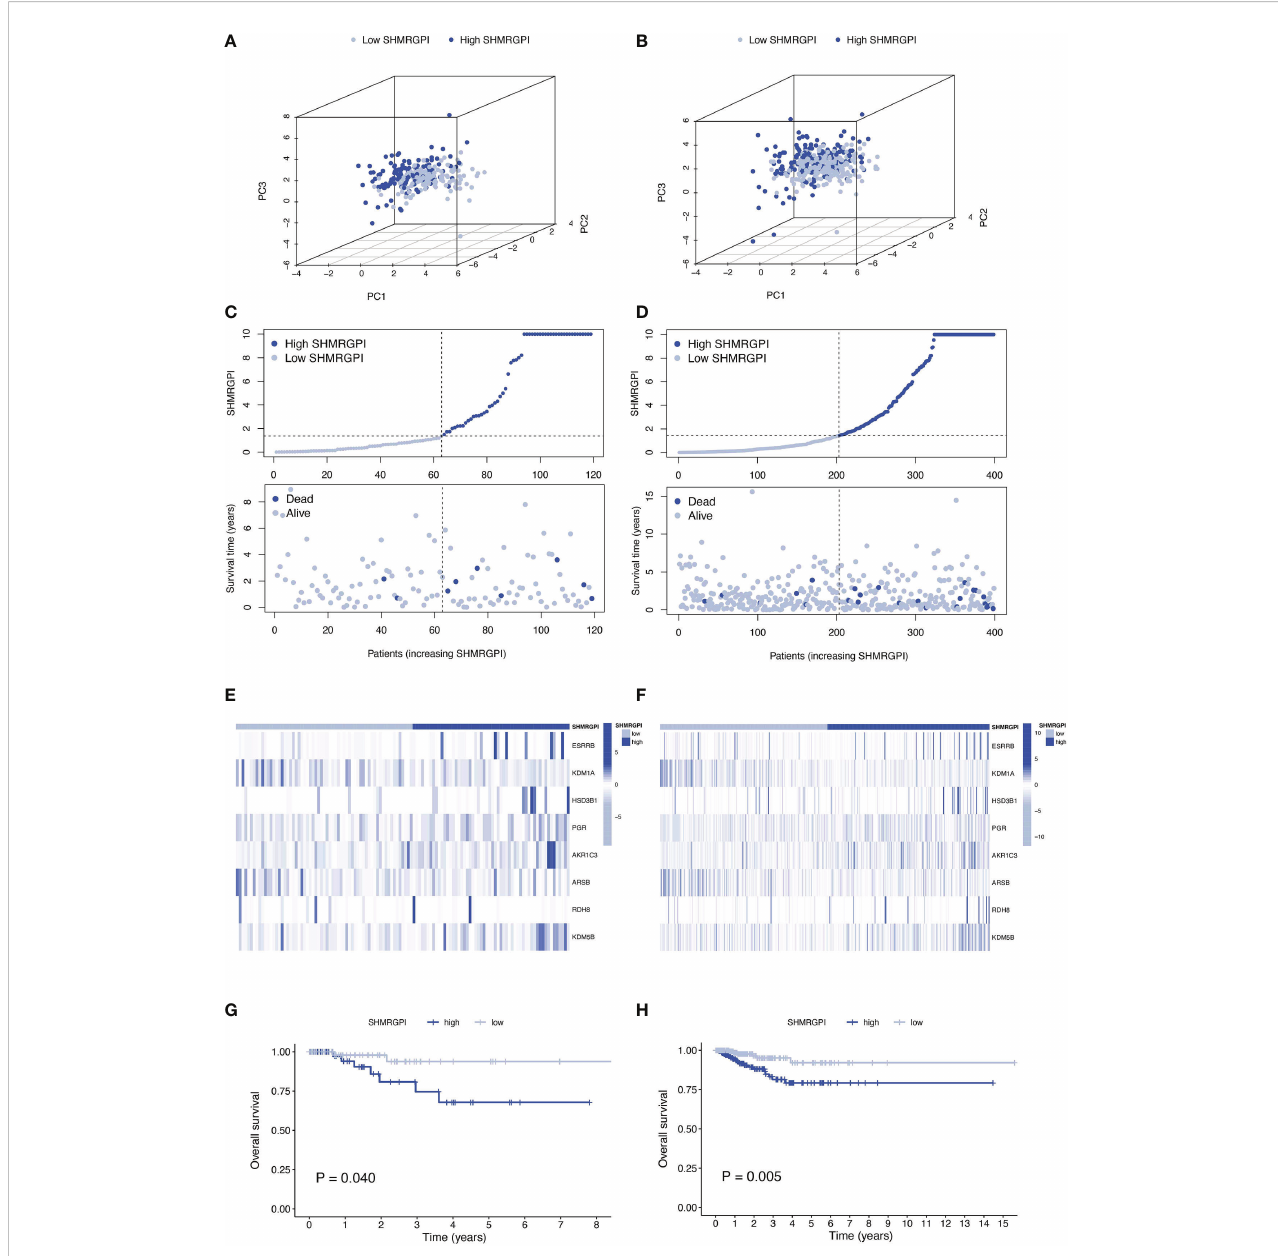
FIGURE 3 Validation of the SHMRGPI in the test and entire cohorts. PCA plot (A) , scatter plot (B) , heat map (C) and Kaplan – Meier curves (D) for the test cohort. PCA plot (E) , scatter plot (F) , heat map (G) , and Kaplan – Meier curves (H) for the entire